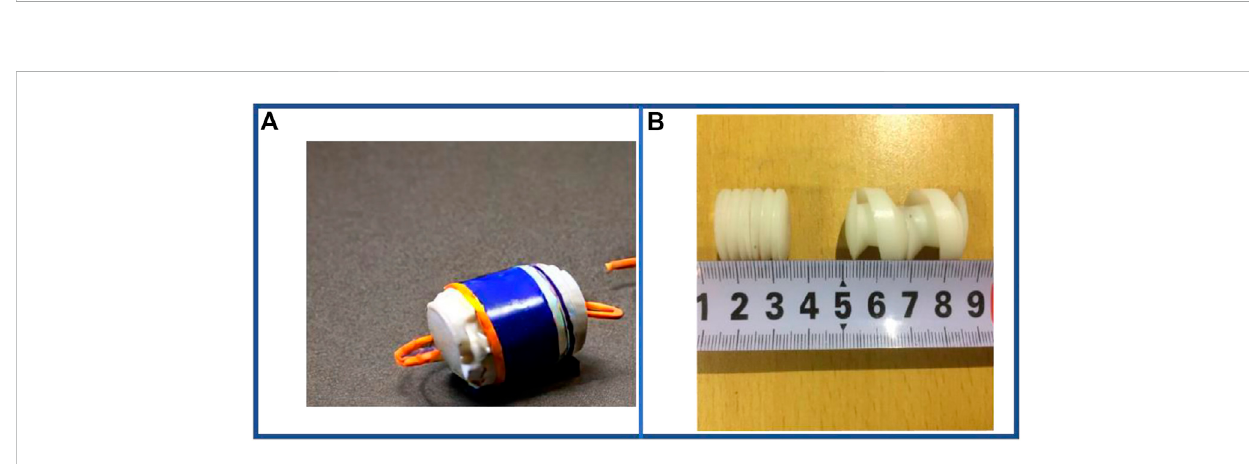
FIGURE 7 Examples of magnetic-driven single-segment earthworm-inspired soft robot. (A) Magnetic-driven capsule robot prototype. (B) Comparison of deformation of body segments (Guo et al., 2018). From Ref. (Guo et al., 2018), used under Creative Commons CC-BY